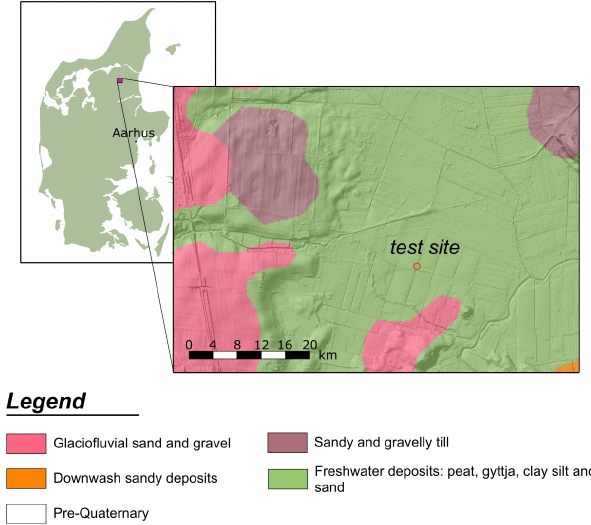
Figure 7. Location and surface geology of the test site according to Surface Geology Map of Denmark 1:200000. The surface geology map of Denmark at a 1:20000 scale is credited to Pedersen et al. (2011), and the map of Denmark is credited to https://MapSVG.com (last access: 25 January